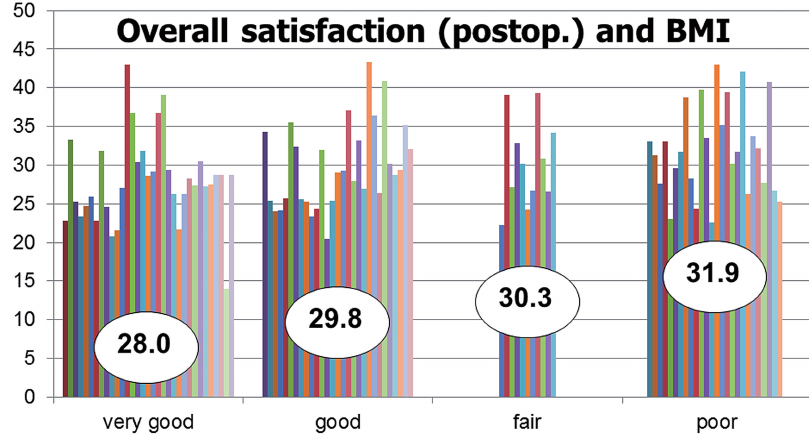
Figure 4 - The average BMI of the patients with a very good, good, fair, and poor result was 28.0, 29.8, 30.3, and 31.9, respectively. A clear trend in favor of a lower BMI is